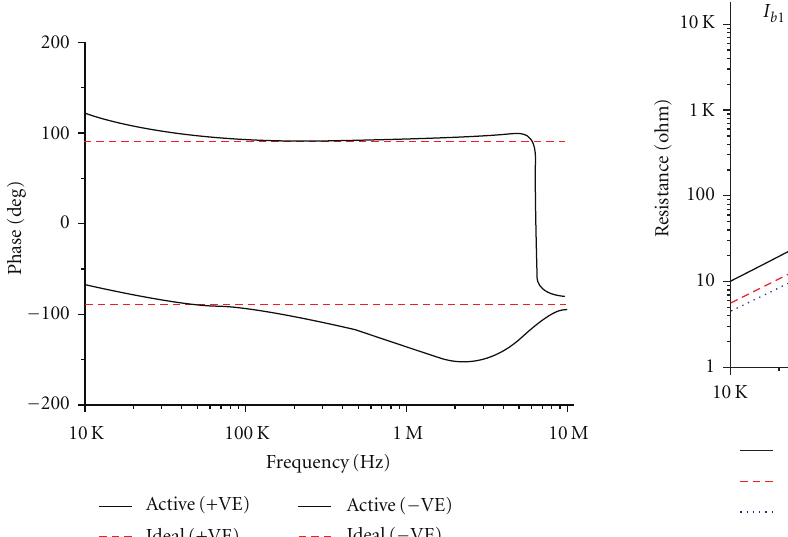
Figure 10: Variation of impedance with I b 2